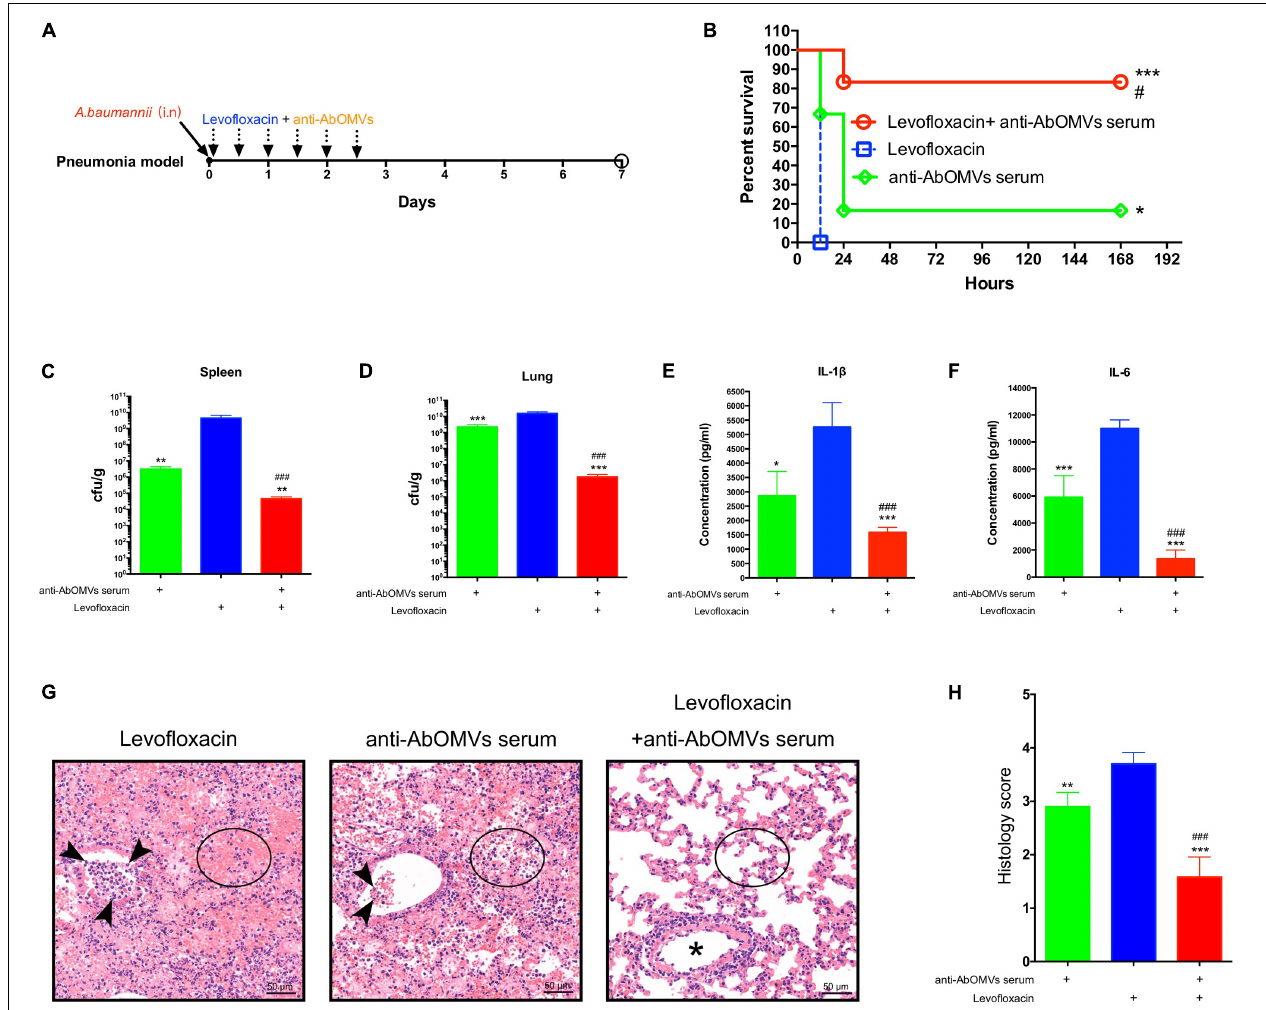
FIGURE 5 | Anti-AbOMV antibodies combined with levofloxacin significantly reduced lung inflammation in mice. (A) Schematic diagram of treatment of A. baumannii pulmonary infection with passive immunization combined with antibiotics. (B) Survival rate of mice infected with A. baumannii and treated with anti-AbOMV serum combined with levofloxacin. The bacterial loads in the spleen (C) and lung (D) were measured 12 h after nasal challenge with Ab112. Approximately 1 mL of lung homogenate supernatant was collected to measure the IL-1 β (E) and IL-6 (F) expression levels by ELISA. (G) The lungs were stained with hematoxylin and eosin. Bar, 50 µ m. Arrowheads, asterisk, and circles indicate neutrophils, bronchi, and alveolar space, respectively. (H) Lung inflammation was scored. ∗ Indicates antibody-antibiotic combination or anti-AbOMVs antiserum compared with the levofloxacin group; # indicates anti-AbOMVs combined with antibiotics compared with anti-AbOMV group; N = 6; ∗ P < 0.05; ∗∗ P < 0.01; ∗∗∗ / ### P <